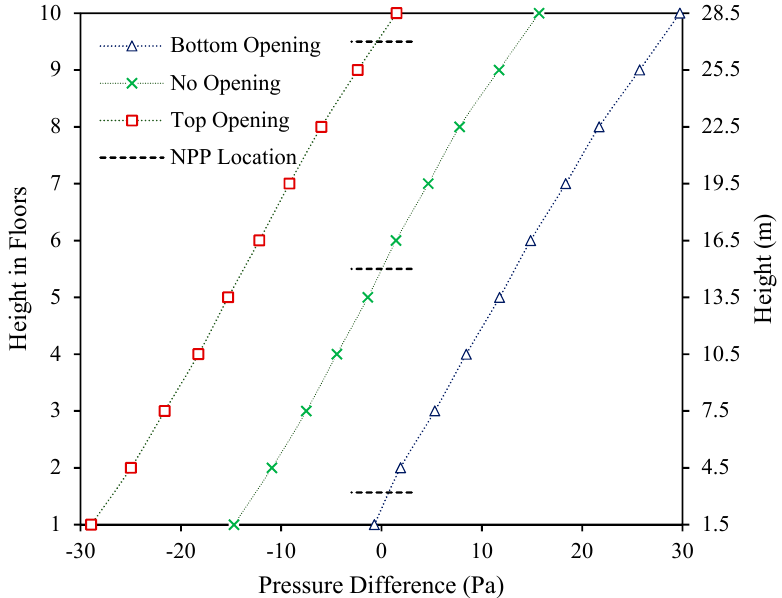
Figure 15. Both scenarios change NPP location and airflow patterns within the building.